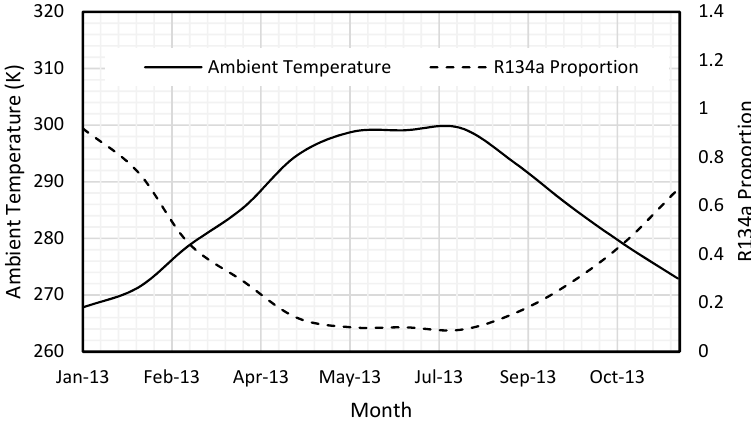
Figure 3. Annual temperature variation and associated changes in working fluid composition for Beijing.